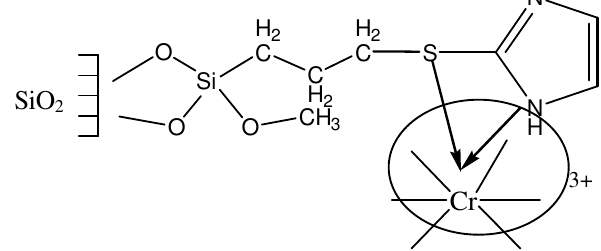
Figure 8. Scheme of the formation of coordination compound between chromium(III) and